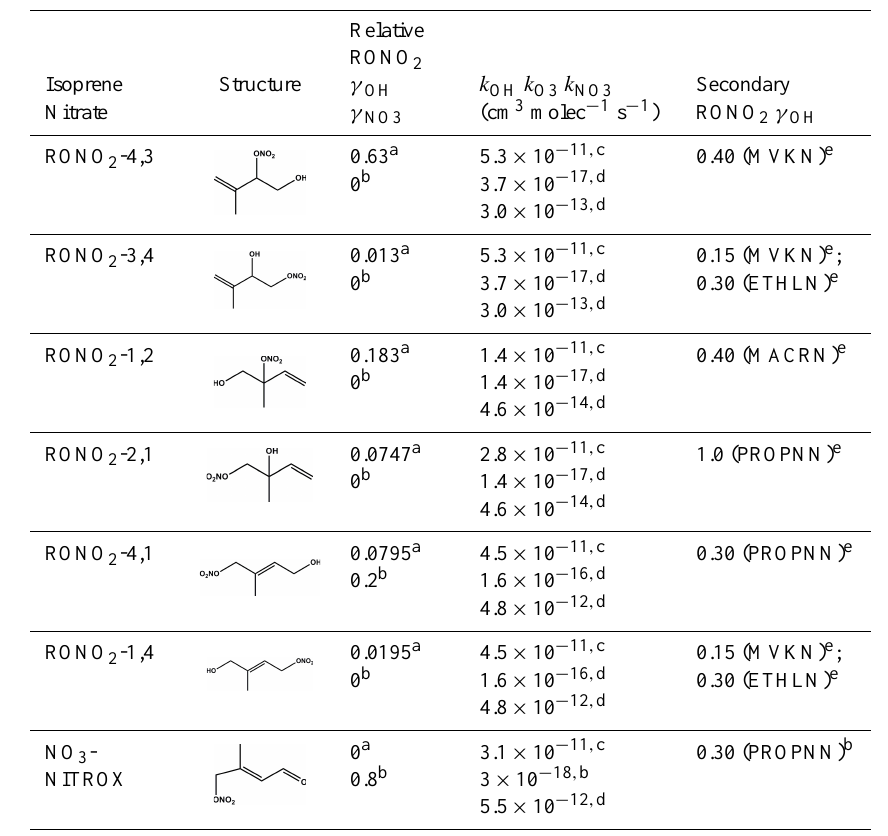
Table 2. Individual primary isoprene nitrate relative yields and corresponding reaction rate constants (units of cm 3 molec − 1 s − 1 ) are shown; secondary isoprene nitrate yields for reaction with OH are shown with the specific species showed in Table 3 and with the abbreviation here listed in parentheses. All primary isoprene nitrates are assumed to have secondary RONO 2 yields of 0.5 for reaction with O 3 . For reaction of all primary isoprene nitrates with NO 3 , yields are assumed to be 0.6 (containing one nitrate group) and 0.4 (dinitrate yield) based on Rollins et al.